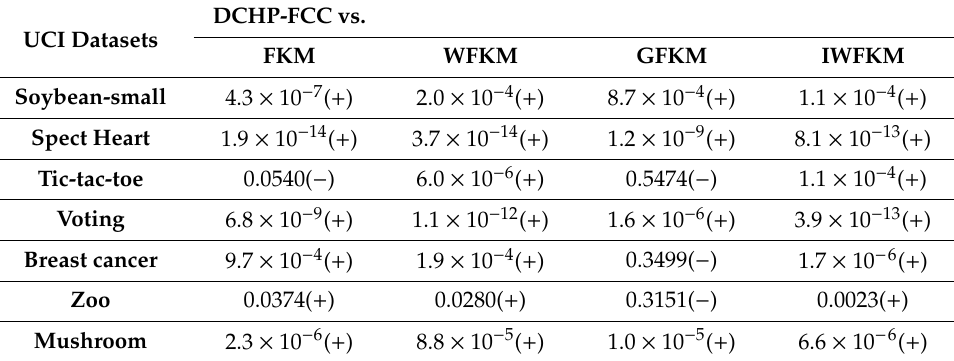
Table 7. The p -value produced by the T -test in terms of